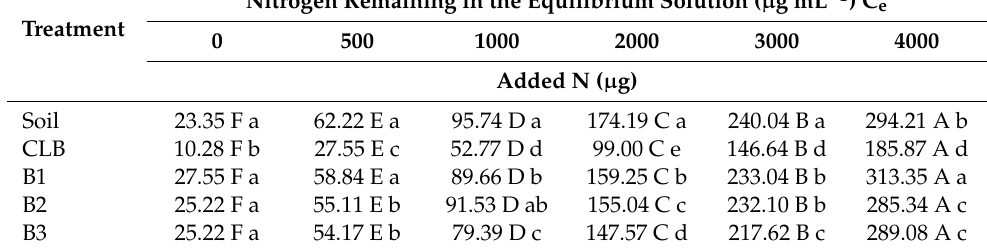
Table 4. Added nitrogen concentration on equilibrium solution nitrogen concentration in di ff erent